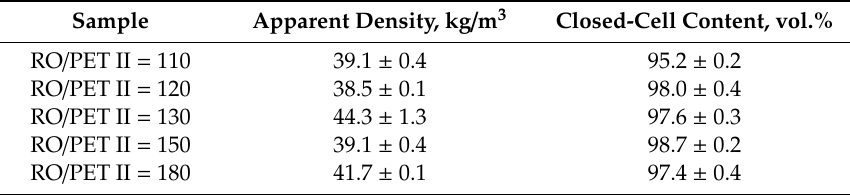
Table 2. Apparent density and closed-cell content of RO / PET series rigid PUR foams.